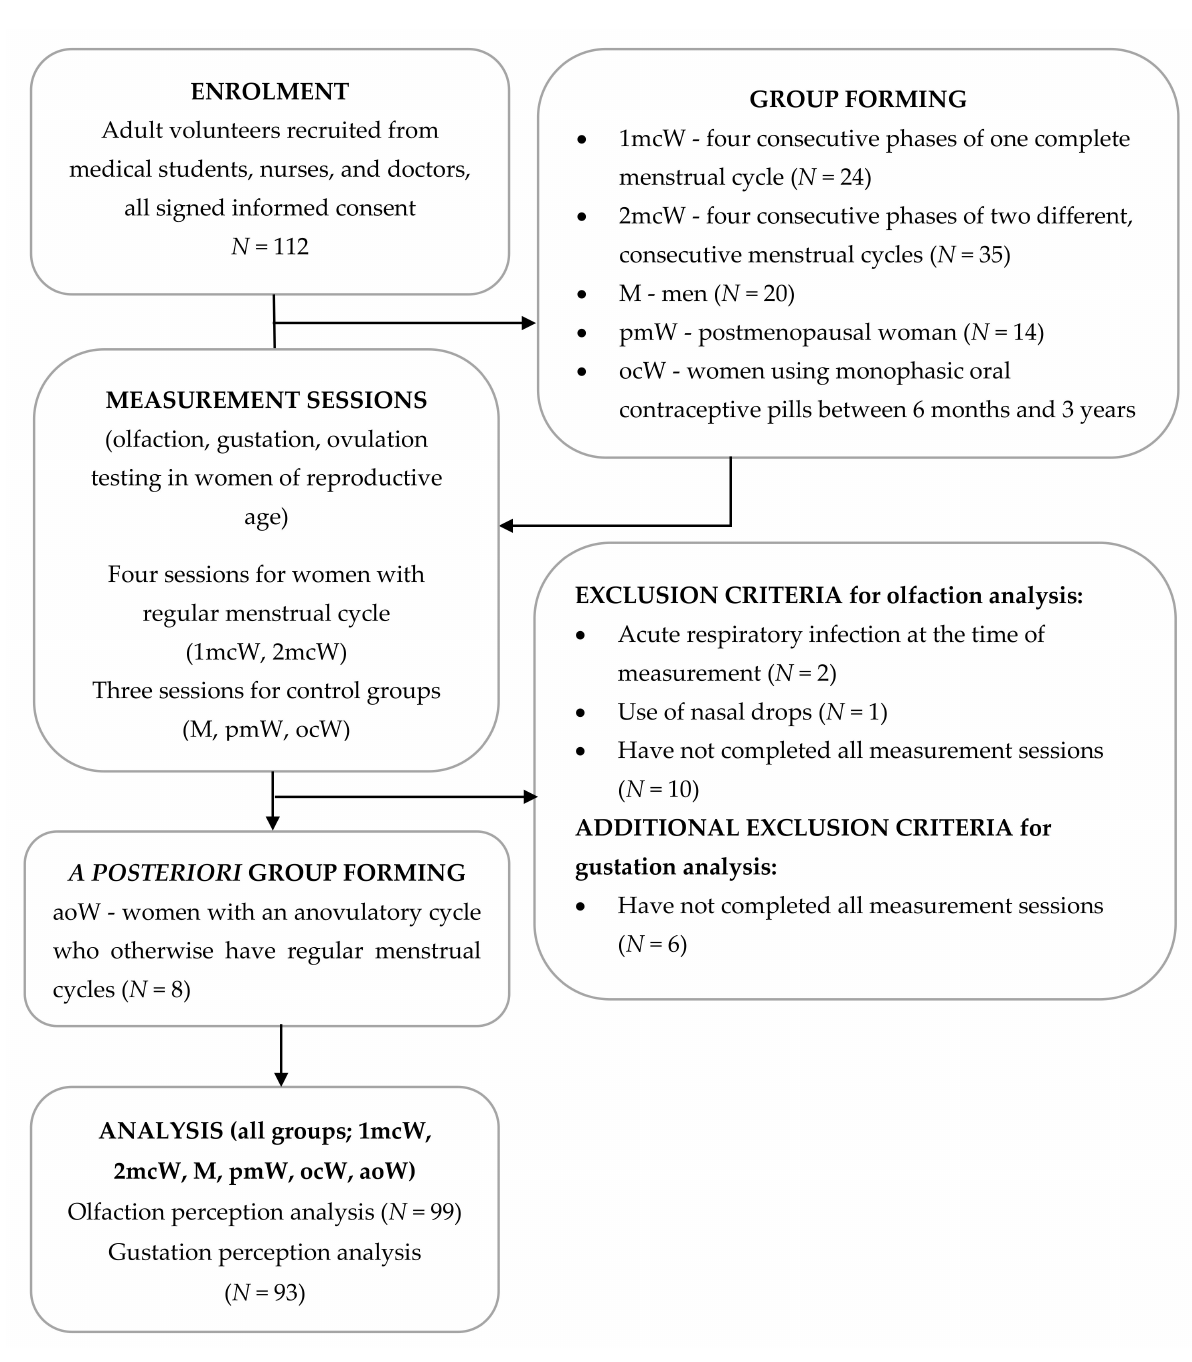
Figure 1. Flowchart of the study. All study groups, exclusion criteria, and numbers of subjects who were lost to follow-up are shown, along with the sample size included in the final analysis of the data (1mcW—women measured across consecutive phases of one complete menstrual cycle; 2mcW—women measured across phases of two different, consecutive menstrual cycles; M—men; pmW—postmenopausal women; ocW—oral contraceptive users; aoW—women with an anovulatory